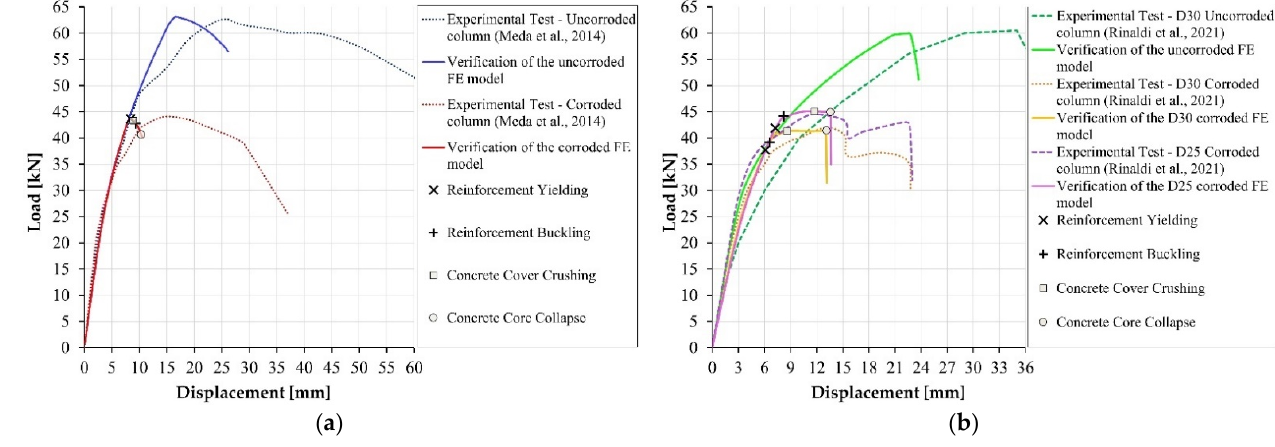
Figure 2. Simulation of corroded reinforced concrete elements by using a numerical model. Verification of the Finite Element Model: ( a ) comparison with the experimental campaign presented in [29] (readaptation of original images); ( b ) experimental campaign presented in [30] (readaptation of original images).